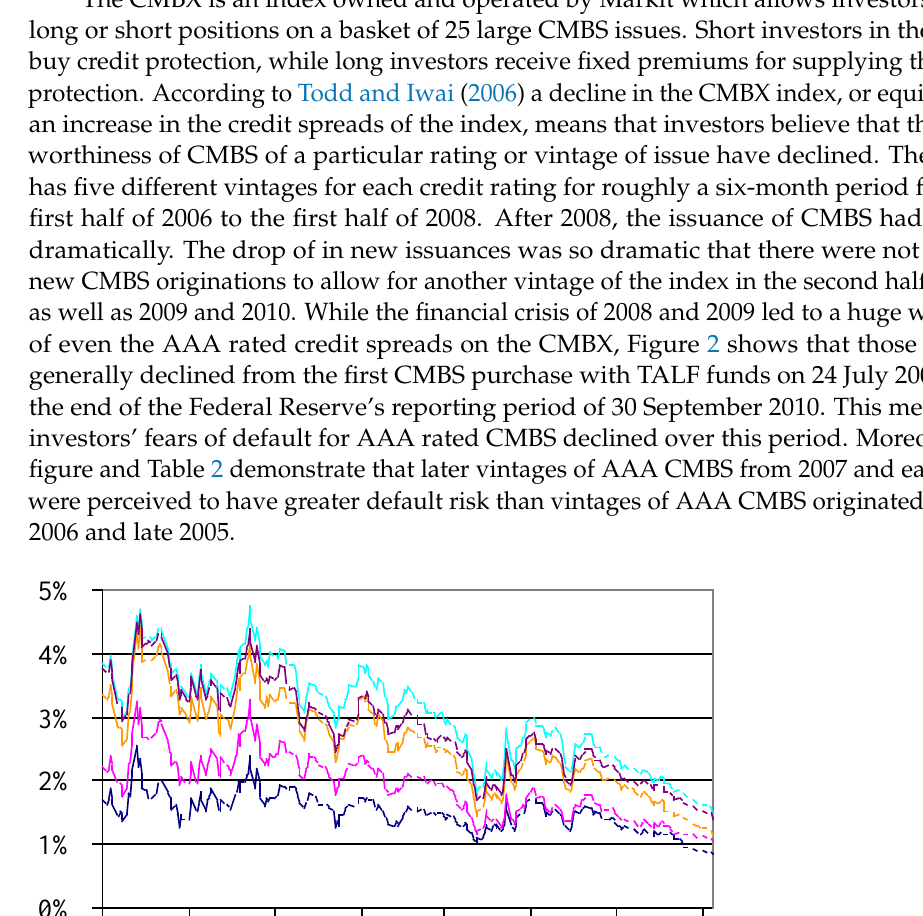
and latest vintage of the CMBX AAA index. Commercial mortgages issued in 2007 were assigned the average credit spread for a given loan date or redemption date of the third and fourth vintages of the CMBX AAA. The third and fourth vintages of the CMBX AAA index debuted in the first and second half of 2007. CMBS issued in 2006 were matched with the second vintage of the AAA index. Finally, all CMBS issued in 2005 or earlier were assigned credit spreads from the CMBX AAA’s first vintage which consisted of CMBS issued in 2005 and early 2006.